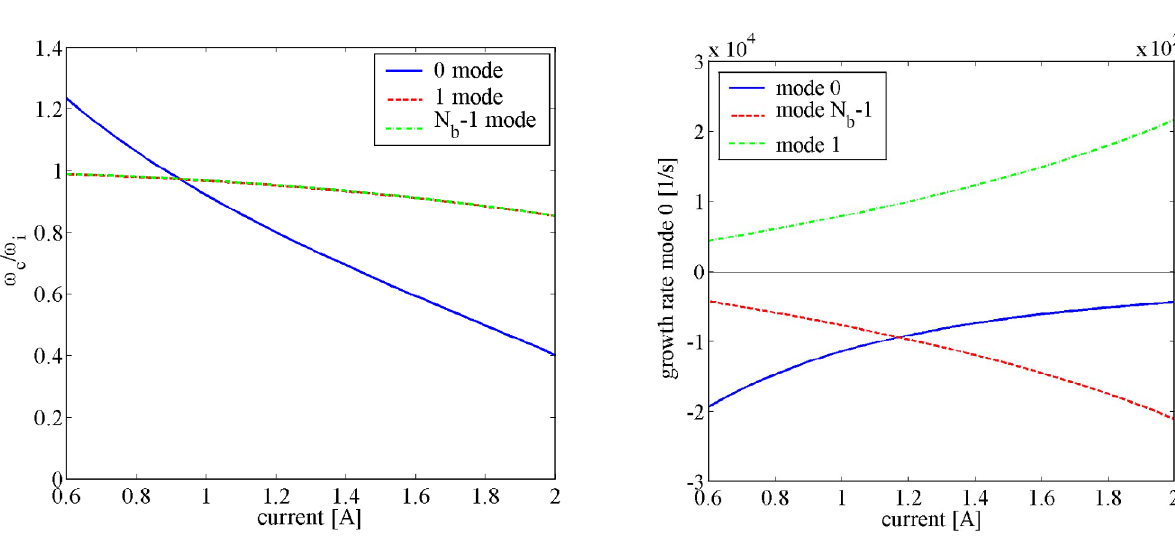
FIG. 5. (Color) CB modes growth and damping rates.FIG. 4. (Color) CB modes frequency shift.